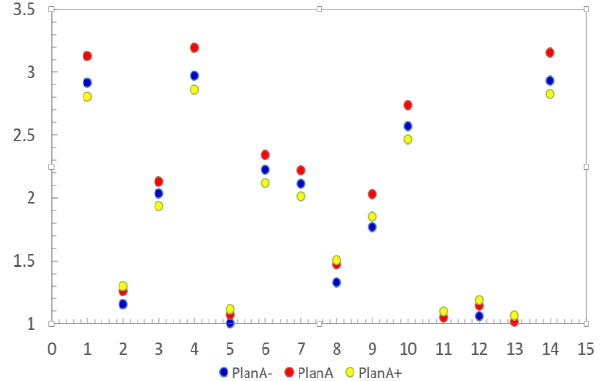
Figure 1. The Water Utilization level of Each